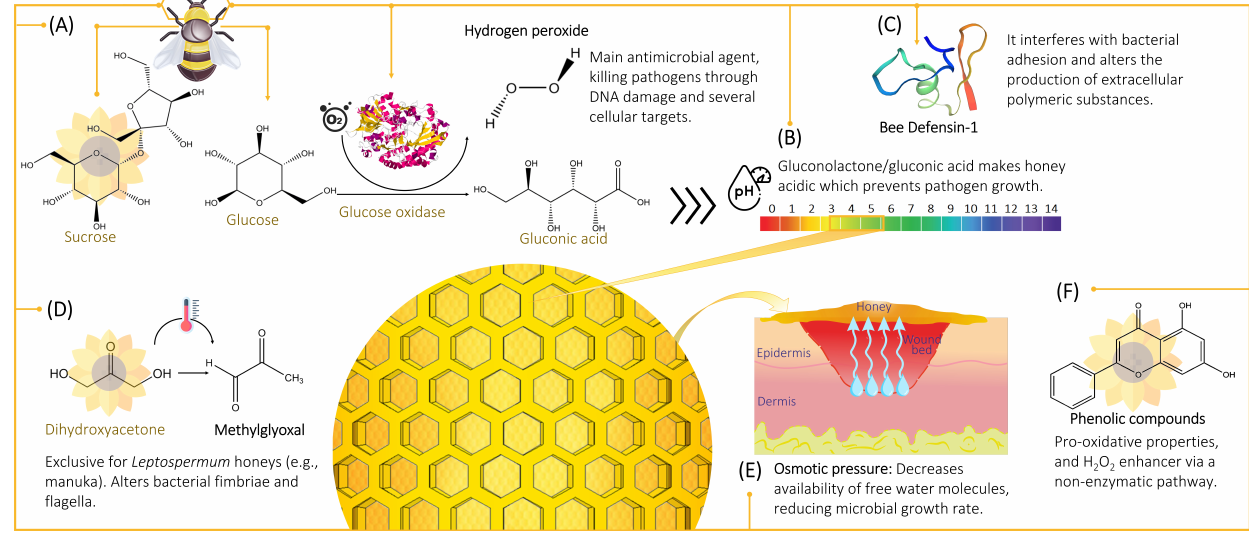
Figure 1. Key antimicrobial components of honey. ( A ) Sucrose from flowers is broken down by the bee into glucose and fructose. The bee’s hypopharyngeal glands secrete GOx. Glucose is then oxidised by the oxidised form of GOx, which results in the production of gluconolactone/gluconic acid and H 2 O 2 . Most of honey’s antimicrobial activity comes from H 2 O 2 , killing pathogens